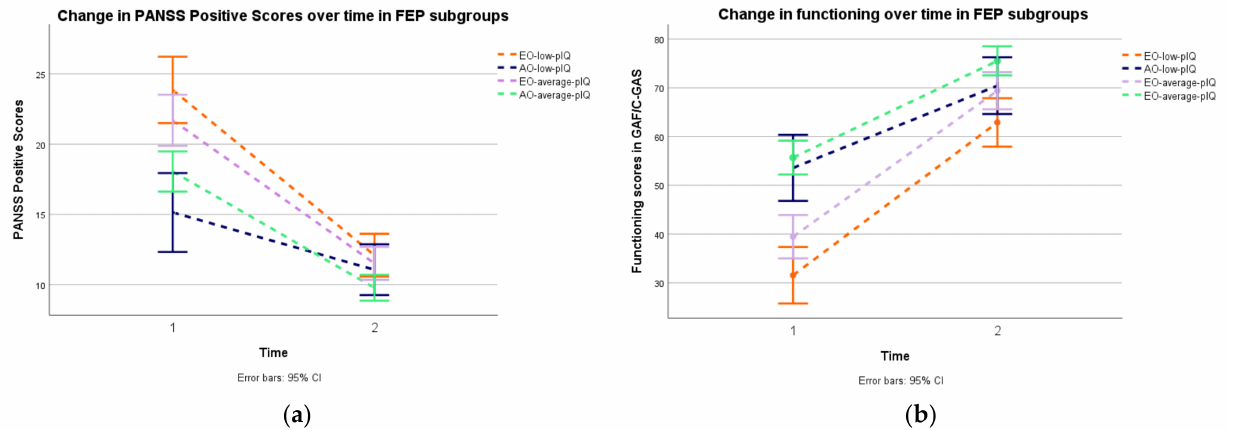
Figure 2. Change in positive symptoms ( a ) and functioning outcome ( b ) in subgroups of patients with a first episode of psychosis from baseline to two-year follow-up. Error bars: 95% CI. EO-low-pIQ: early onset with premorbid IQ < 85; AO-low-pIQ: adult onset with premorbid IQ < 85. EO-average-pIQ: early onset with premorbid IQ ≥ 85. AO-average-pIQ: adult onset with premorbid IQ ≥